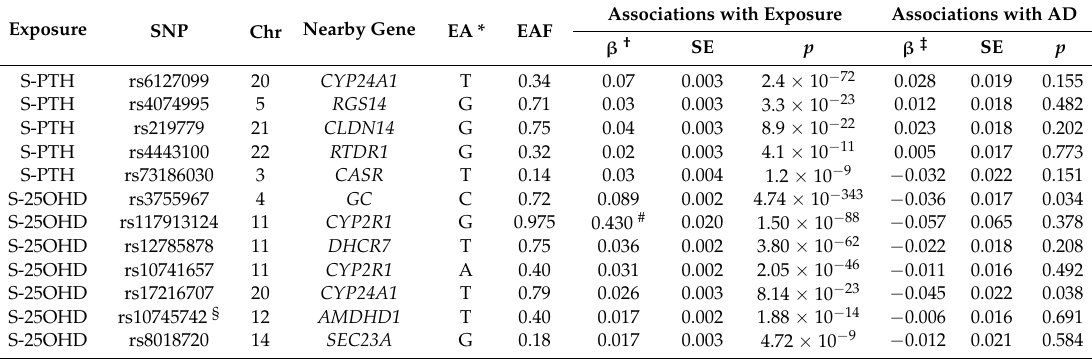
Table 1. Characteristics of the single nucleotide polymorphisms associated with S-PTH and S-25OHD concentrations and their associations with AD. Associations with Exposure Associations with EAF